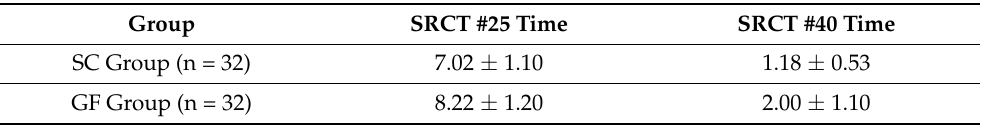
Table 1. Working time (min) calculated to perform the secondary treatment with RB #25 and com- pleted with RB #40. Mean ± Standard Deviations.